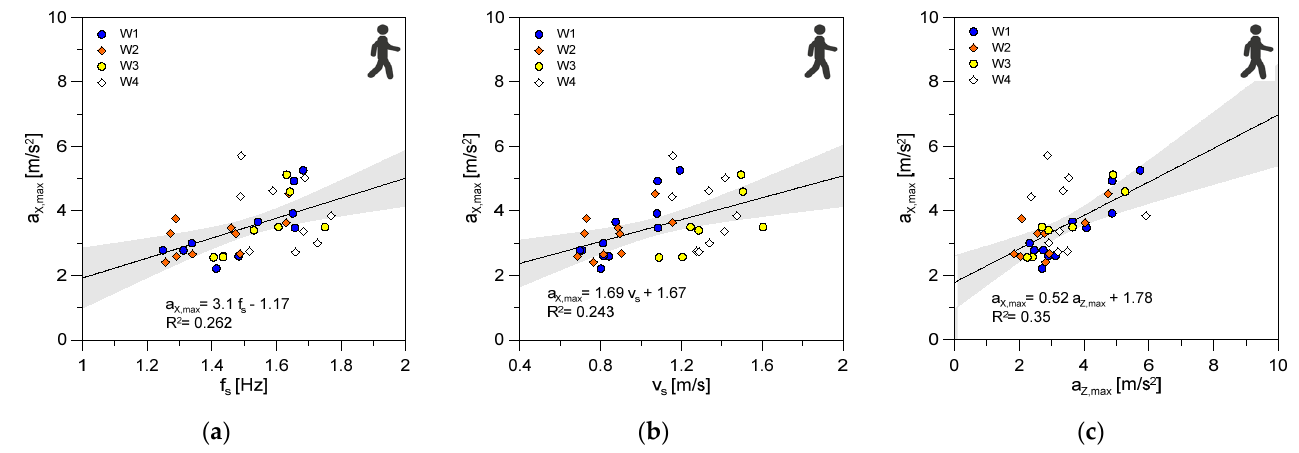
Figure 12. Summary of experimental records for W1–W4 configurations, in terms of transversal ac- celeration peak as a function of ( a ) walking frequency, ( b ) walking speed, and ( c ) vertical acceleration peak. The 95% confidence interval is shown in grey colour.